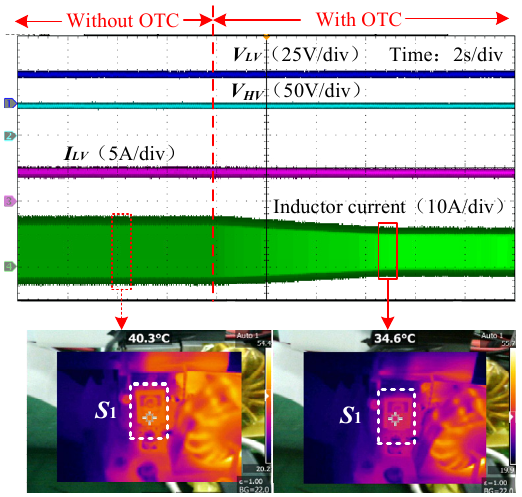
Figure 15. Experimental waveforms in V LV = 24 V, full load.